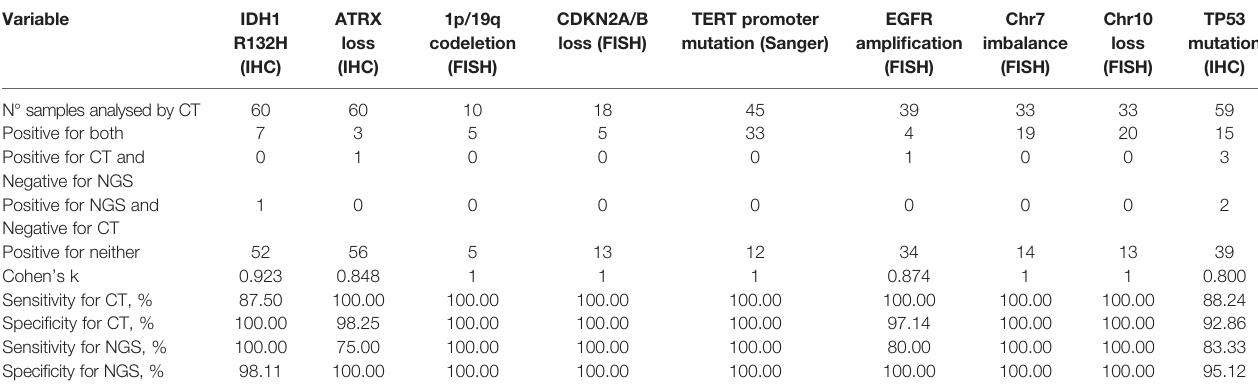
TABLE 1 | Concordance between conventional testing and